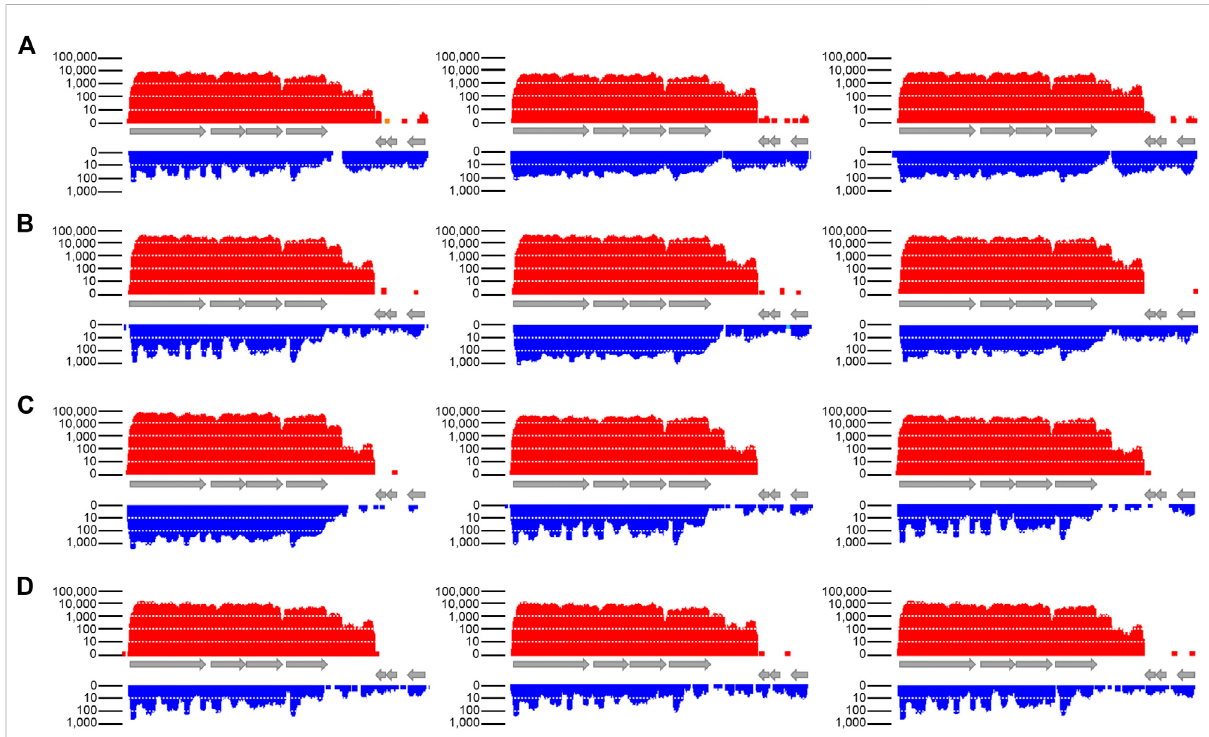
FIGURE 4 Transcriptional activity of sol mRNA and Assolrna as displayed in the program TraV. Columns, biological replicates; (A) transcription data from sampling in early exponential growth phase; (B) transcription data from sampling after butyrate peak; (C) transcription data from sampling after acetate peak; (D) transcription data from sampling in stationary growth phase. Red, transcriptional activity of sol mRNA; blue, transcriptional activity of Assolrna. Transcriptional activity is the calculated base coverage from mapped reads (Dietrich et al., 2014). Grey arrows represent genes encoding butyraldehyde dehydrogenase, CoA-transferase subunits α and β , acetoacetate decarboxylase, hypothetical protein, and two Spo0E-like sporulationregulatoryproteinsfromlefttoright(Cspa_c56880 – Cspa_c56940).Eachcolumnrepresentsonebiologicalreplicate,i.e., n =3.Thereis a sharp decrease in transcriptional activity at the end of the displayed transcript. Transcriptional activity at both ends of the fi gure were not cut off intentionally, they indeed ended there. This fi gure is modi fi ed from Baur (2022).